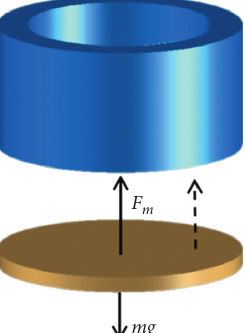
Figure 4: A simplified mechanical model of the valve cover at a certain